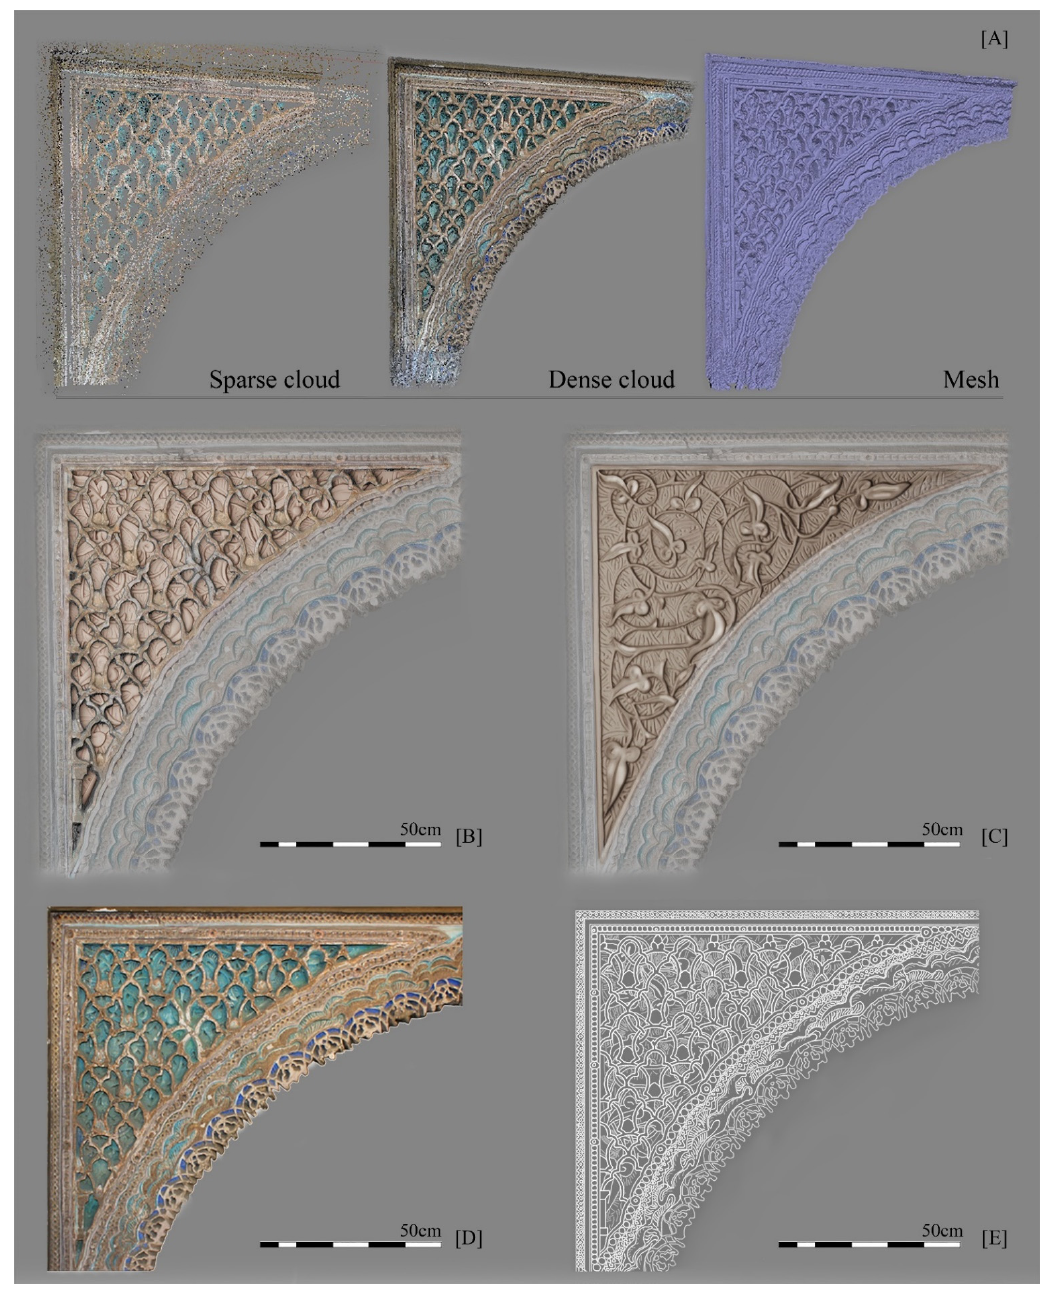
Figure 10. Data processing in Metashape software ( A ); results after the process of 3D modeling of the spandrel ( B ). Hypothesis of the hidden layout made by the authors based on the previous photogrammetric survey ( C ). Planimetric survey of the spandrel: photograph ( D ) and planimetric map drawn by the authors ( E ) (authors’ own